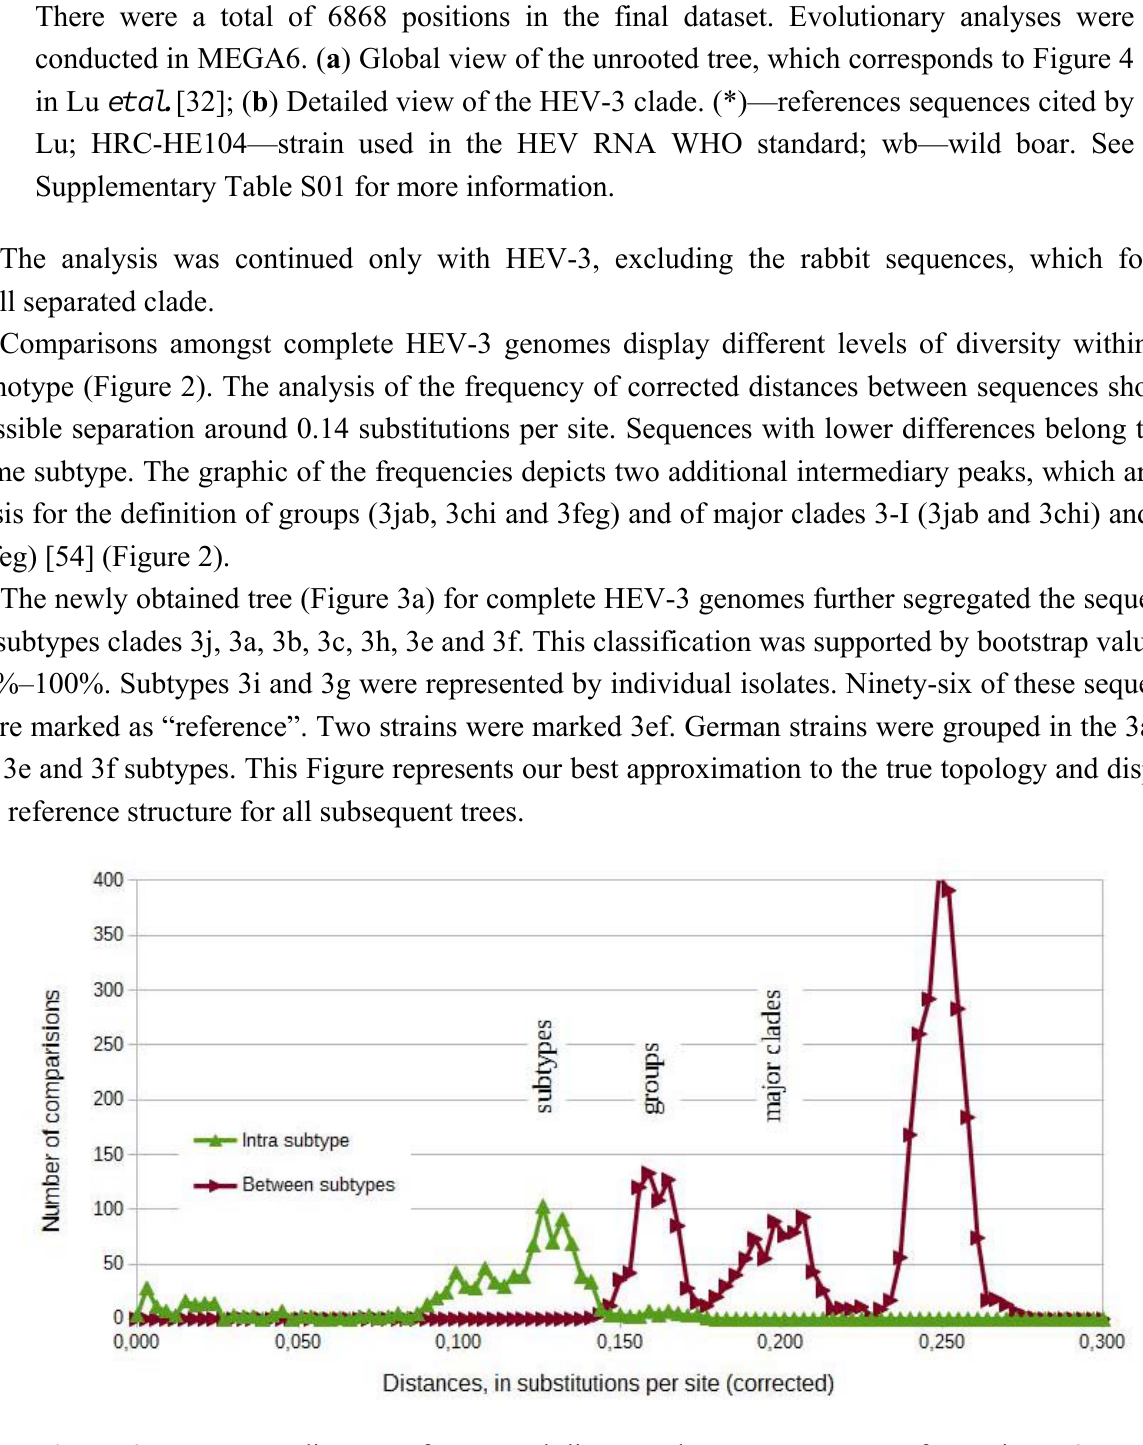
Figure 2. Frequency diagram of corrected distances between sequences from Figure 3a.